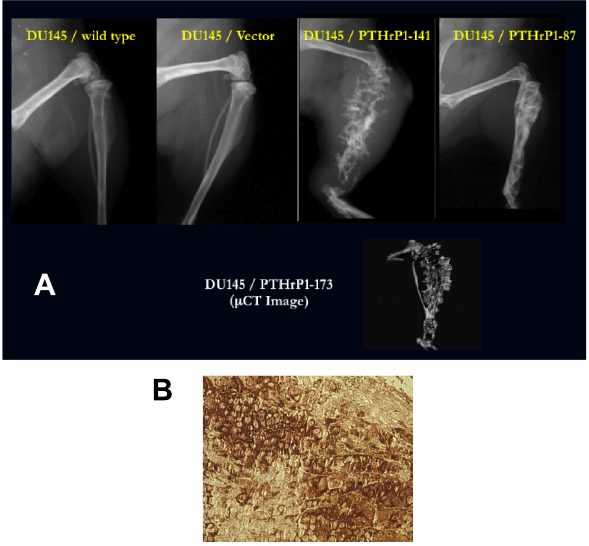
Figure 5. PTHrP Promotes Destruction of Bone in an Intraos- seous Model. A) X-ray and uCT Images showing the effect of PTHrP overexpression on bone destruction in an intraosseous mouse model. Tibia of mice receiving PTHrP-overexpressing DU 145 displayed significant destruction of bone compared to control. B) The DU 145– GFP–PTHrP1-173 prostate tumor was removed from the mouse, fixed and stained immunohistochemically for PTHrP using a biotin-strepta- vidin- horseradish peroxidase system (brown reaction product indicates PTHrP expression).